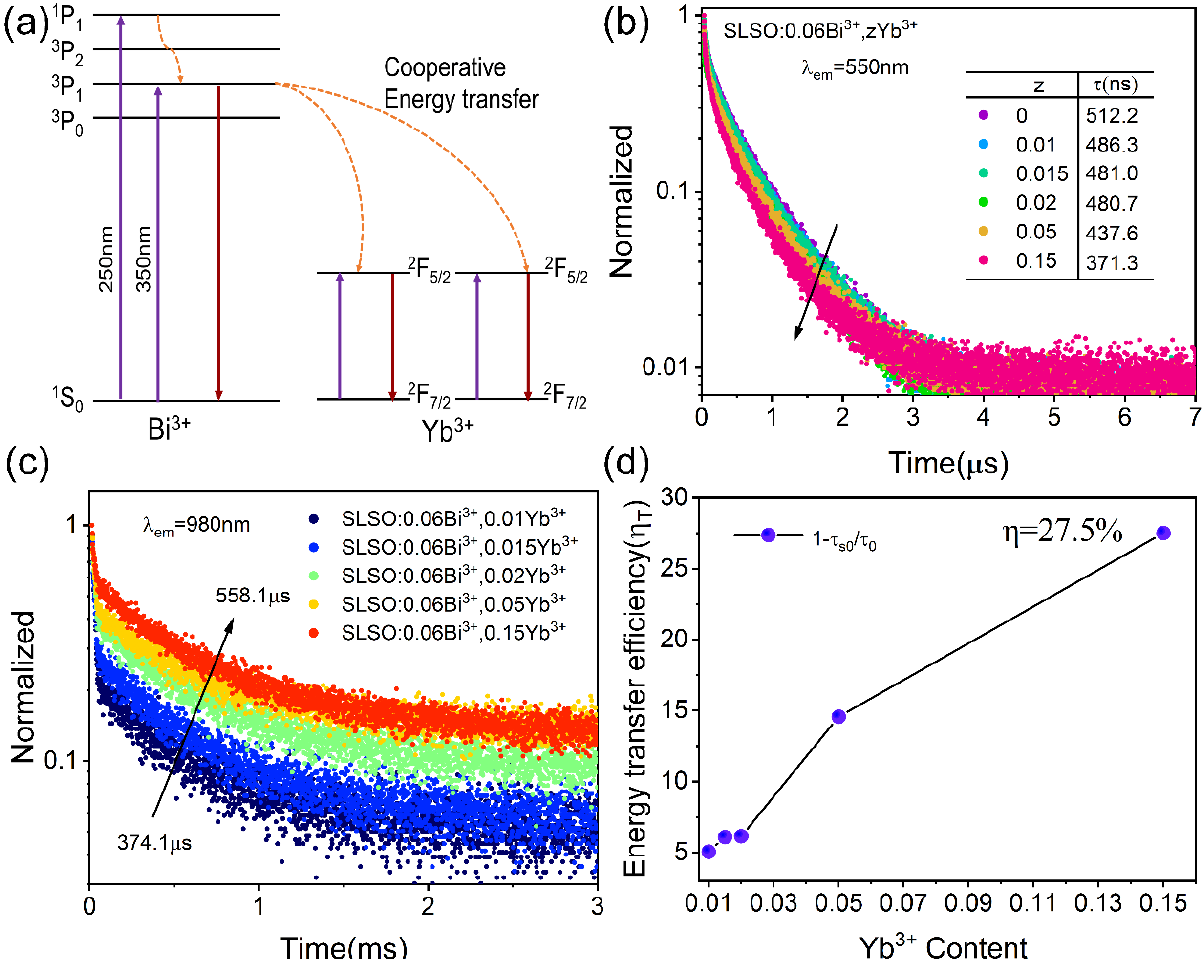
Figure 9. ( a ) Schematic energy level diagram of Bi 3+ and Yb 3+ ions in SLSO; ( b ) decay curves of Bi 3+ ; ( c ) decay curves of Yb 3+ ; ( d ) energy transfer efficiencies of SLSO:0.06Bi 3+ , z Yb 3+ .